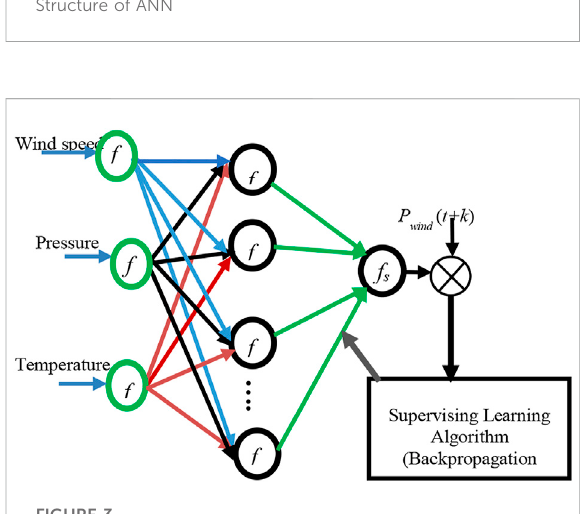
FIGURE 2 Structure of ANN